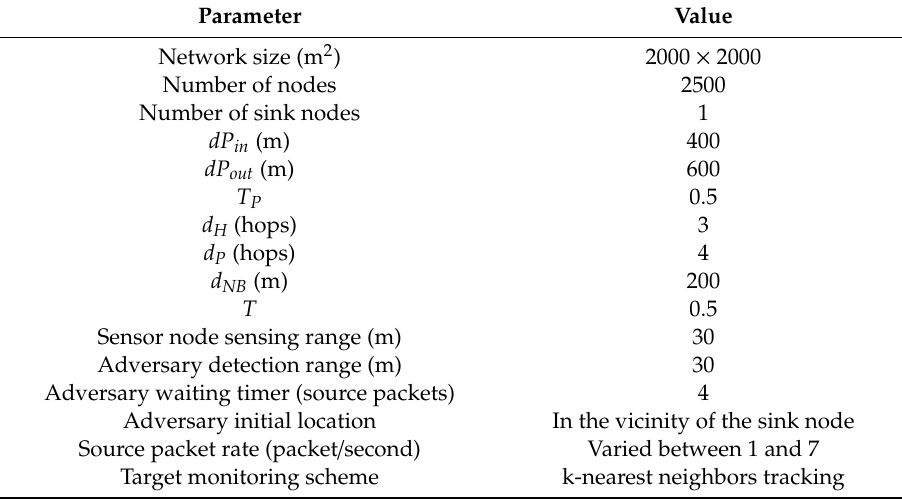
Table 6. Network simulation